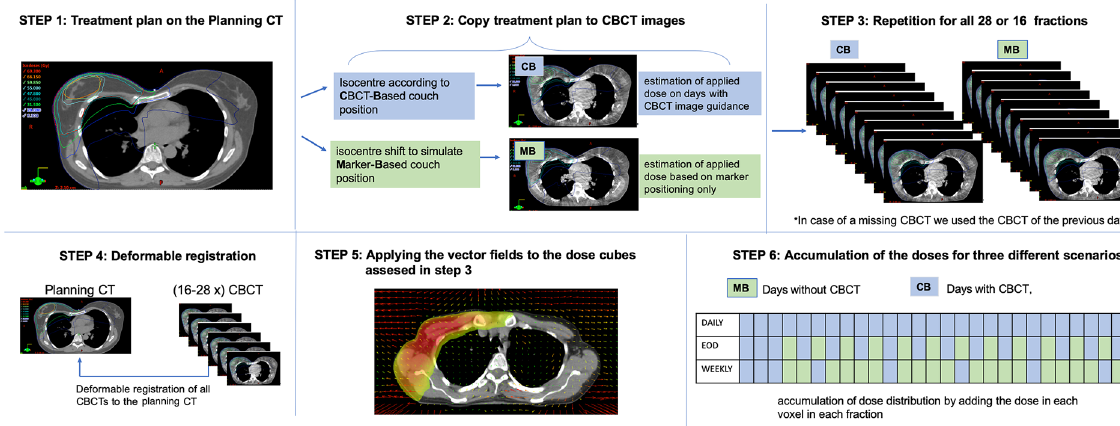
Figure 1. Workflow used to estimate the delivered dose in dependence of CBCT- frequency. CB conebeam- based positioning, MB marker-based